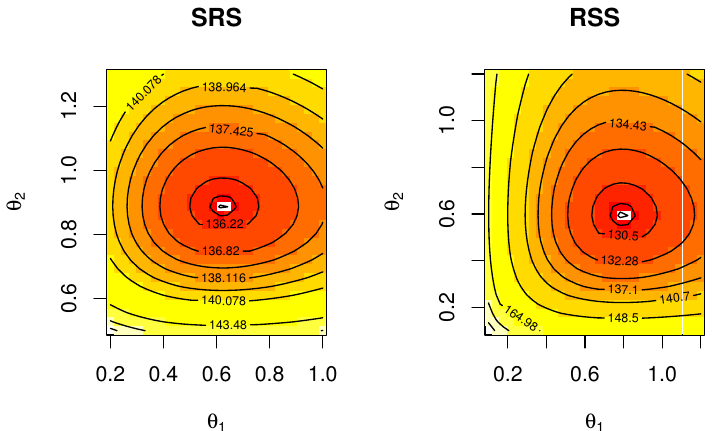
Figure 5. Contour plot of likelihood for parameter estimation by SRS and RSS method for bank- ing data.